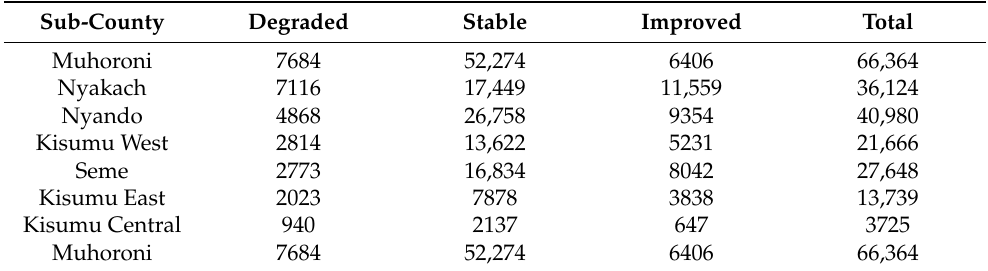
Table 7. The extent of land status (ha) between 2016–2020 in the Kisumu subcounty. Sub-County